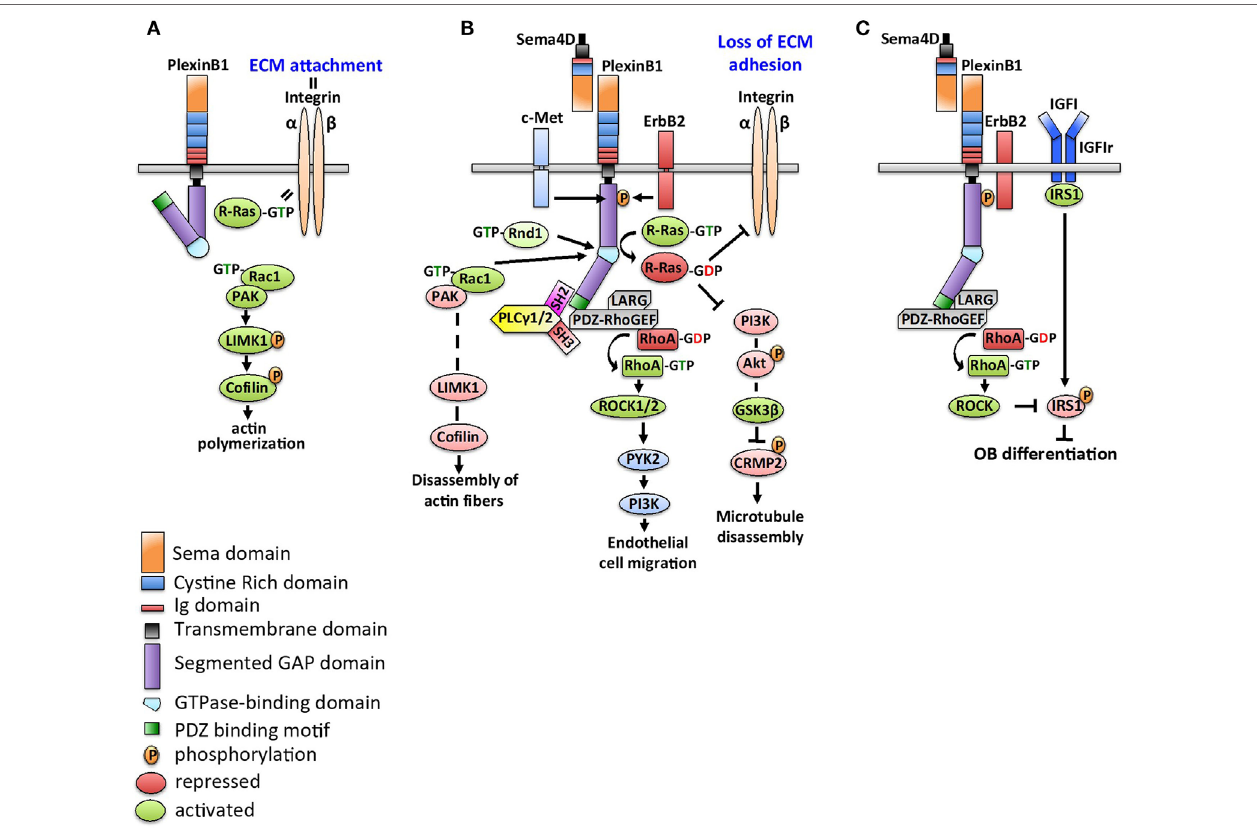
FiGURe 1 | Schematics of Sema4D/Plexin-B1 signaling. (A) In the absence of Sema4D, the cytoplasmic tail of Plexin-B1 is in an inactive conformation. R-Ras is in a GTP-bound state to collaborate with integrin and control cellular adhesion to the extracellular matrix (ECM). With Plexin-B1 in an inactive state, Rac activates p21-activated kinase (PAK) to trigger LIMK1 signaling and downstream phosphorylation of cofilin, which results in increased actin polymerization and microtubule assembly. (B) Sema4D binding to Plexin-B1 alters the Plexin-B1 conformation, recruits Rac1 to the complex, and inhibits activation of the PAK–LIMK1–cofilin signaling cascade. In addition, R-Ras recruitment to the Sema4D/Plexin-B1 complex inhibits its ability to regulate integrin-mediated activation, resulting in increased cell motility. Deactivation of R-Ras further decreases PI3K-Akt GSK3 β pathway, which leads to deactivation of CRMP-2 and subsequent microtubule disassembly. In an ErbB2-dependent signaling step, PLC γ 1/2 is recruited to Plexin-B1 via its SH2 domain. Structural interaction of the PLC γ 1/2 SH3 domain triggers PDZ- RhoGEF/LARG complex, resulting in RhoA activation. Active GTP-RhoA acts on Raf and Rho-associated kinases (ROCK1/2), which in turn stimulate PYK2 to induce cell invasiveness and migration. (C) Sema4D-Plexin-B1 signaling inhibits osteoblast differentiation. Plexin-B1/ErbB2-dependent RhoA activation stimulates activation of downstream kinase ROCK, which phosphorylates the insulin receptor substrate 1 (IRS1). This causes suppression of insulin like growth factor (IGF1)-dependent signaling and blocks osteoblast